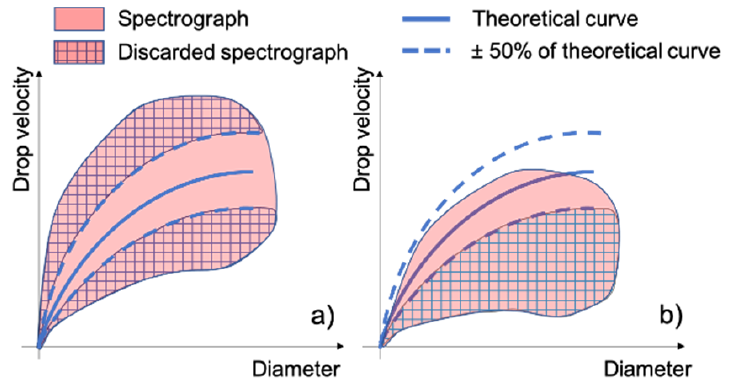
Figure 2. Schematic representation of literature filtering in still air ( a ) and in turbulent and windy conditions ( b ).